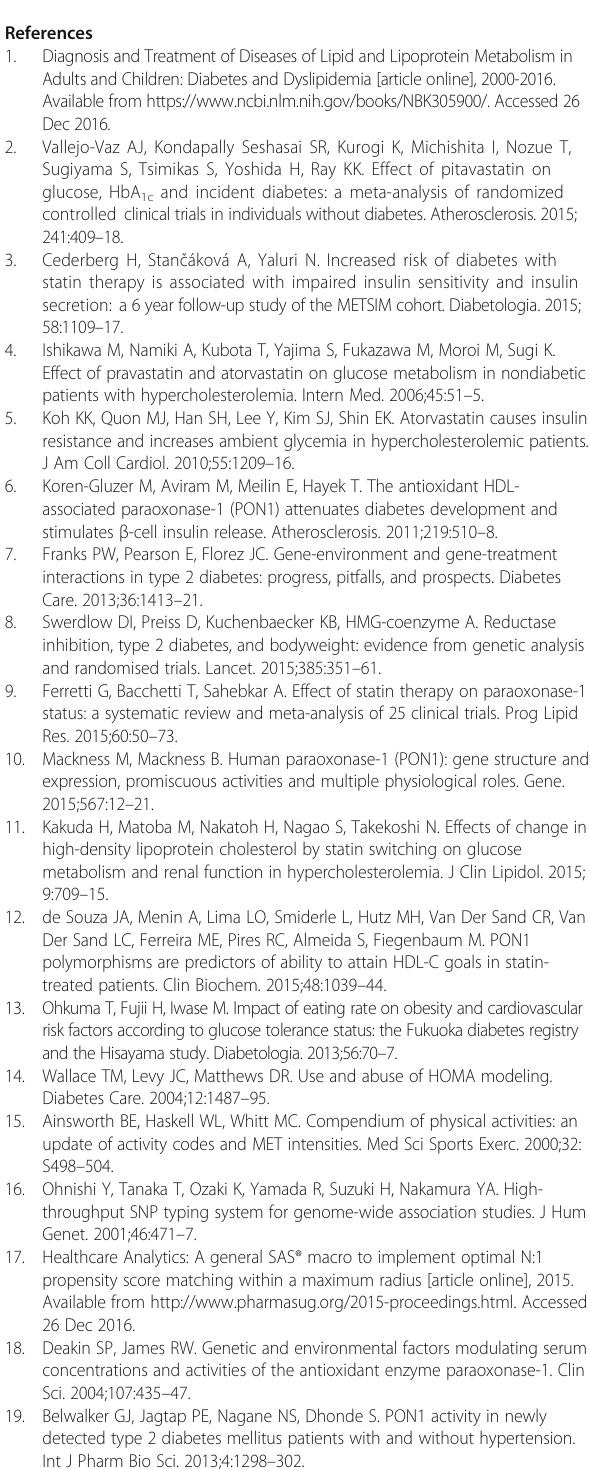
Abbreviations CVD: Cardiovascular disease; DPP4-I: Inhibitors of type 4 dipeptidyl peptidase; FPG: Fasting plasma glucose; HOMA2-% β : Homeostasis model assessment β